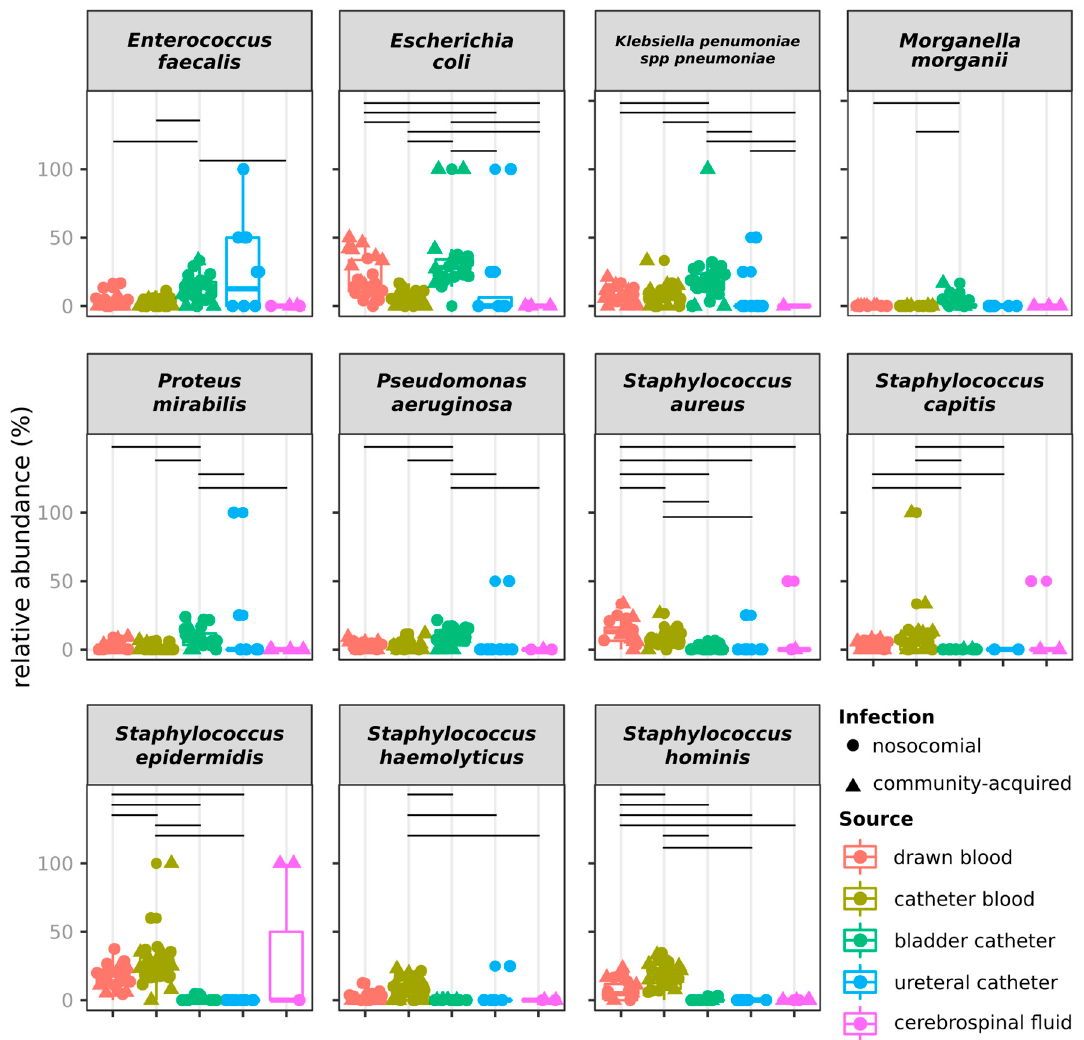
Figure 4. Bacterial species with relative abundances differing among sources of isolation over the whole dataset. Horizontal lines indicate significant differences (Wilcoxon test fdr < 0.05).